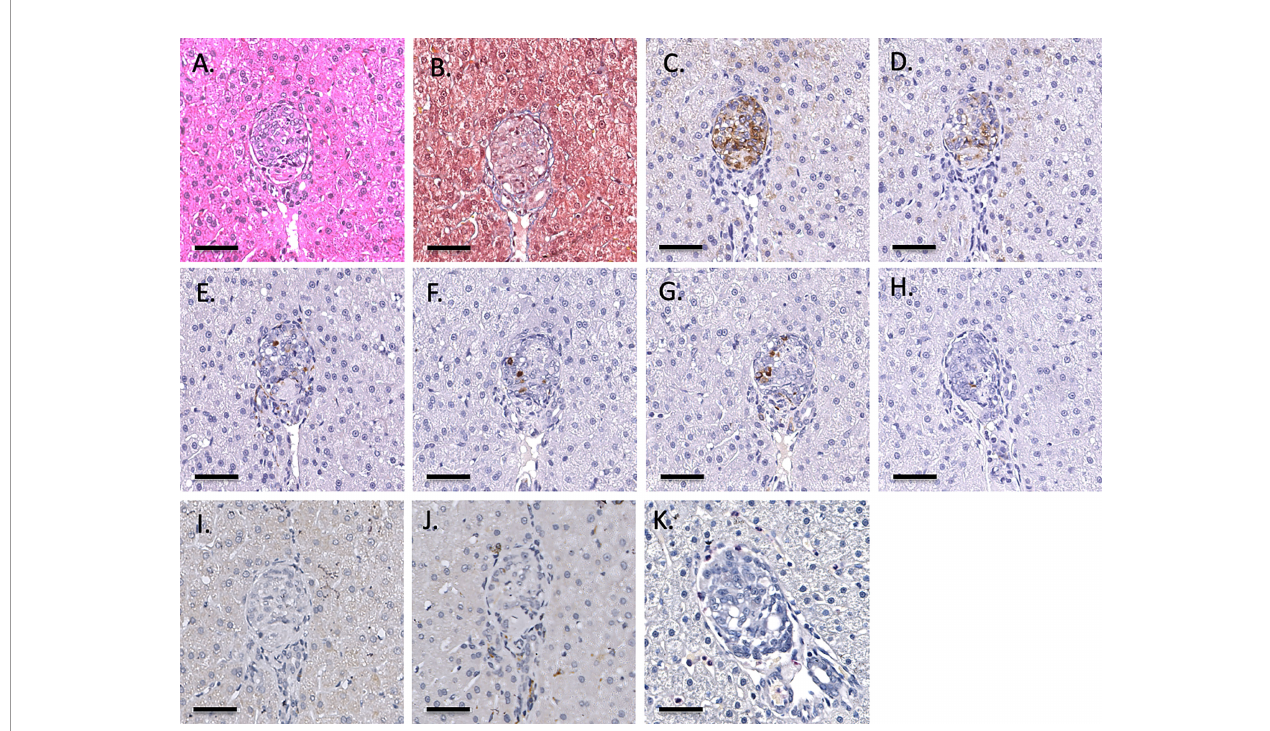
FIGURE 3 | Representative 1-hr liver biopsy stained for H&E (A) , MSB (B) , CD55 (C) , CD59 (D) , chromogranin A (E) , insulin (F) , glucagon (G) , somatostatin (H) , CD20 (I) , CD3 (J) and neutrophil elastase (K) . Note the absence of signs of IBMIR or leukocytic in fi ltration. Magni fi cation X400, indicator bar 50